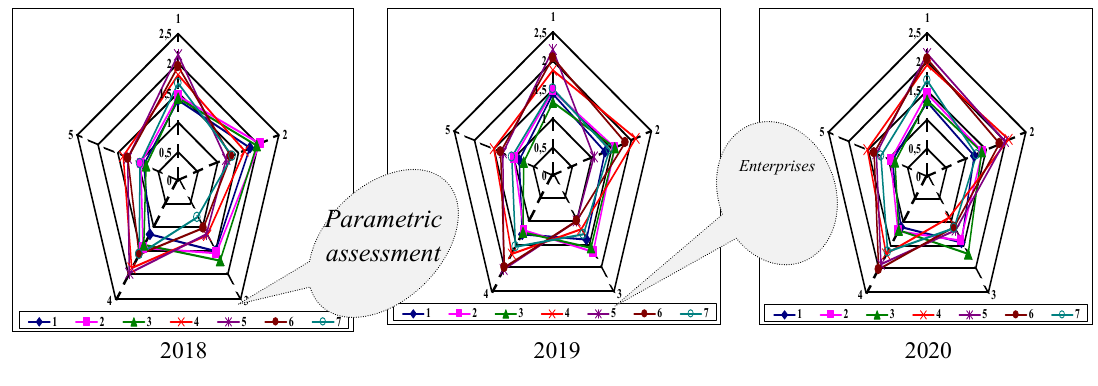
Fig. 3. Enterprises’ competitiveness polygons in